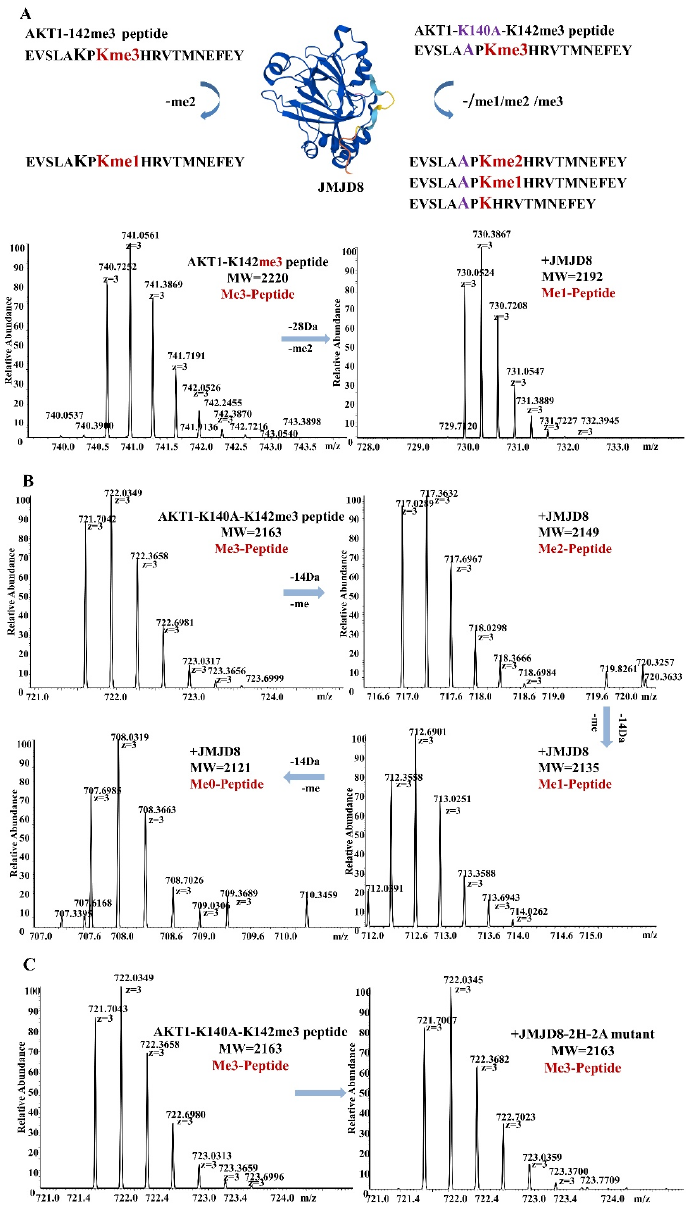
Figure 1. LC–MS analysis of demethylation of trimethylated lysine AKT1 peptides (AKT1 ‐ K142me3 ( A ) and AKT1 ‐ K140A ‐ K142me3 ( B )) by truncated recombinant catalytic domain constructs of JMJD8. ( C ) LC ‐ MS analysis of demethylation of trimethylated lysine AKT1 peptides (AKT1 ‐ K140A ‐ K142me3) by JMJD8 ‐ 2H ‐ 2A